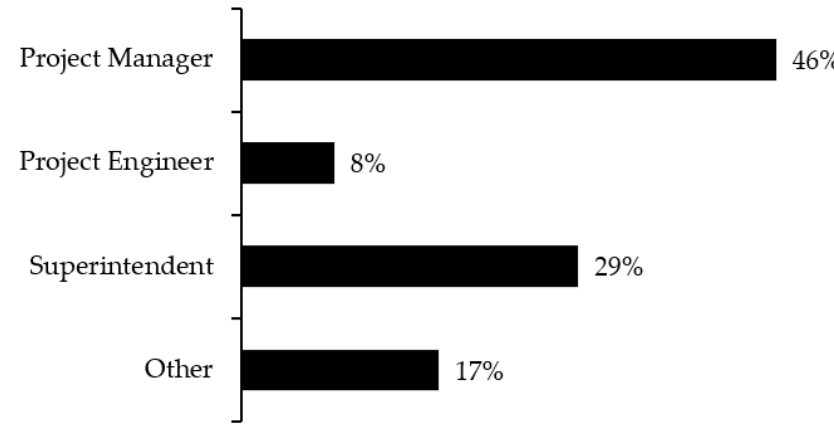
Figure 2. Typical site utilization plan developer.